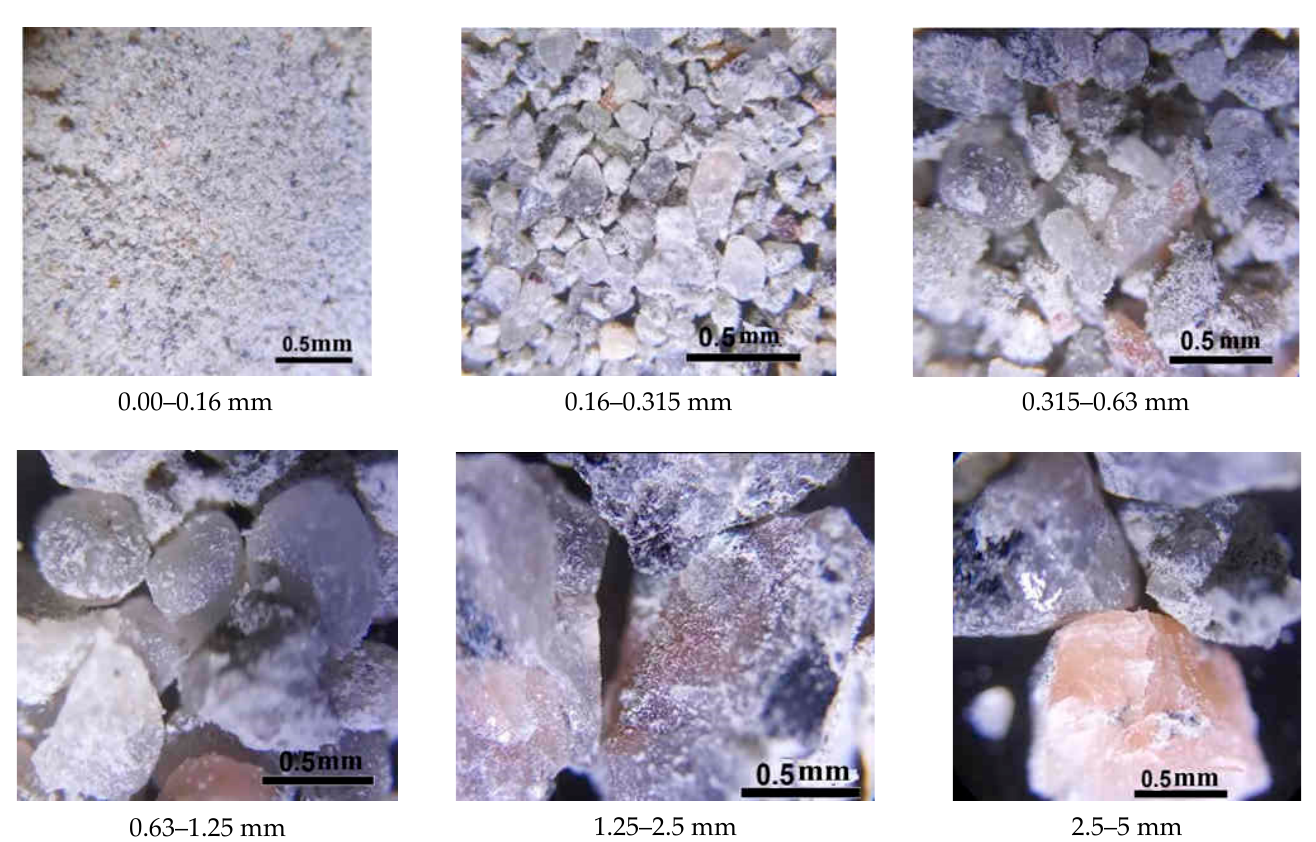
Figure 2. XRD patterns of screening fractions of the concrete scrap crushing. Different colored lines indicate the results for different fractions, and the red line at the bottom is drawn for ease of reference.